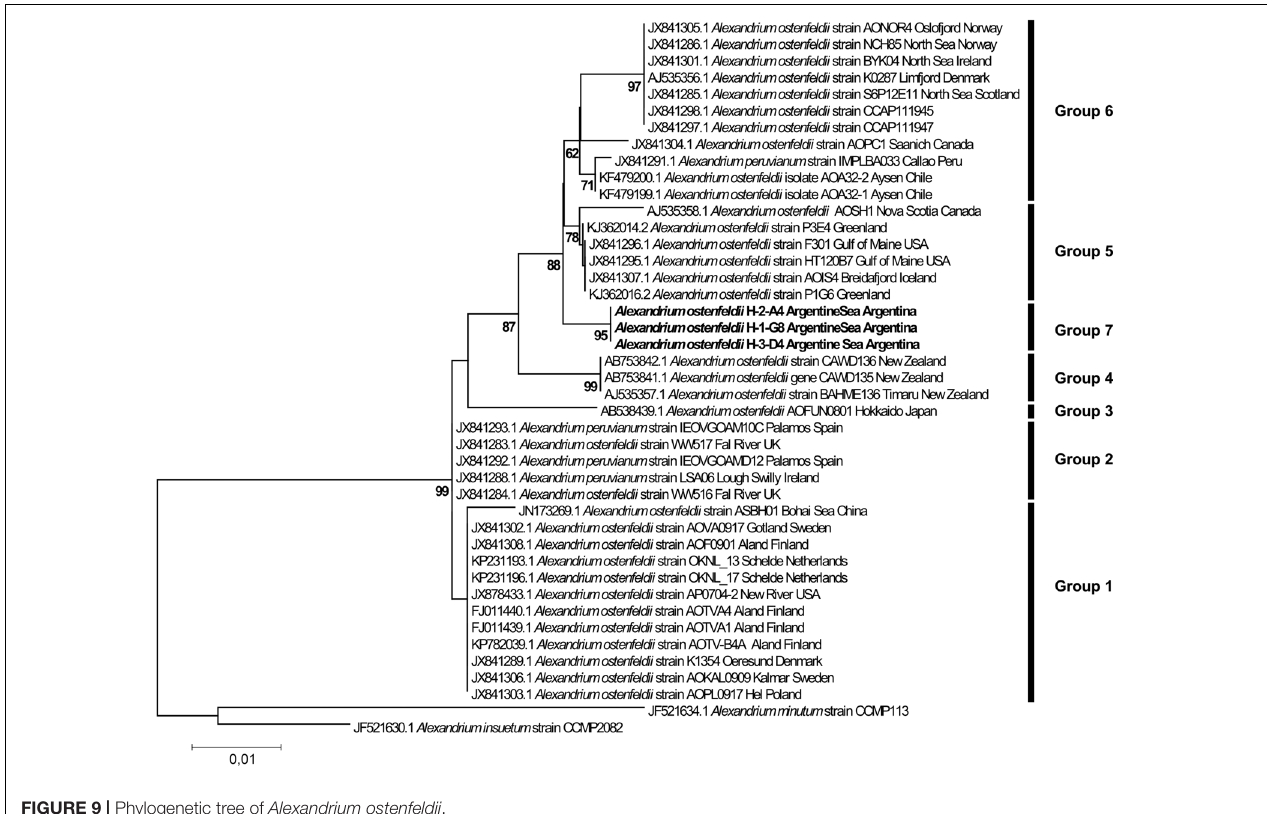
FIGURE 9 | Phylogenetic tree of Alexandrium ostenfeldii .